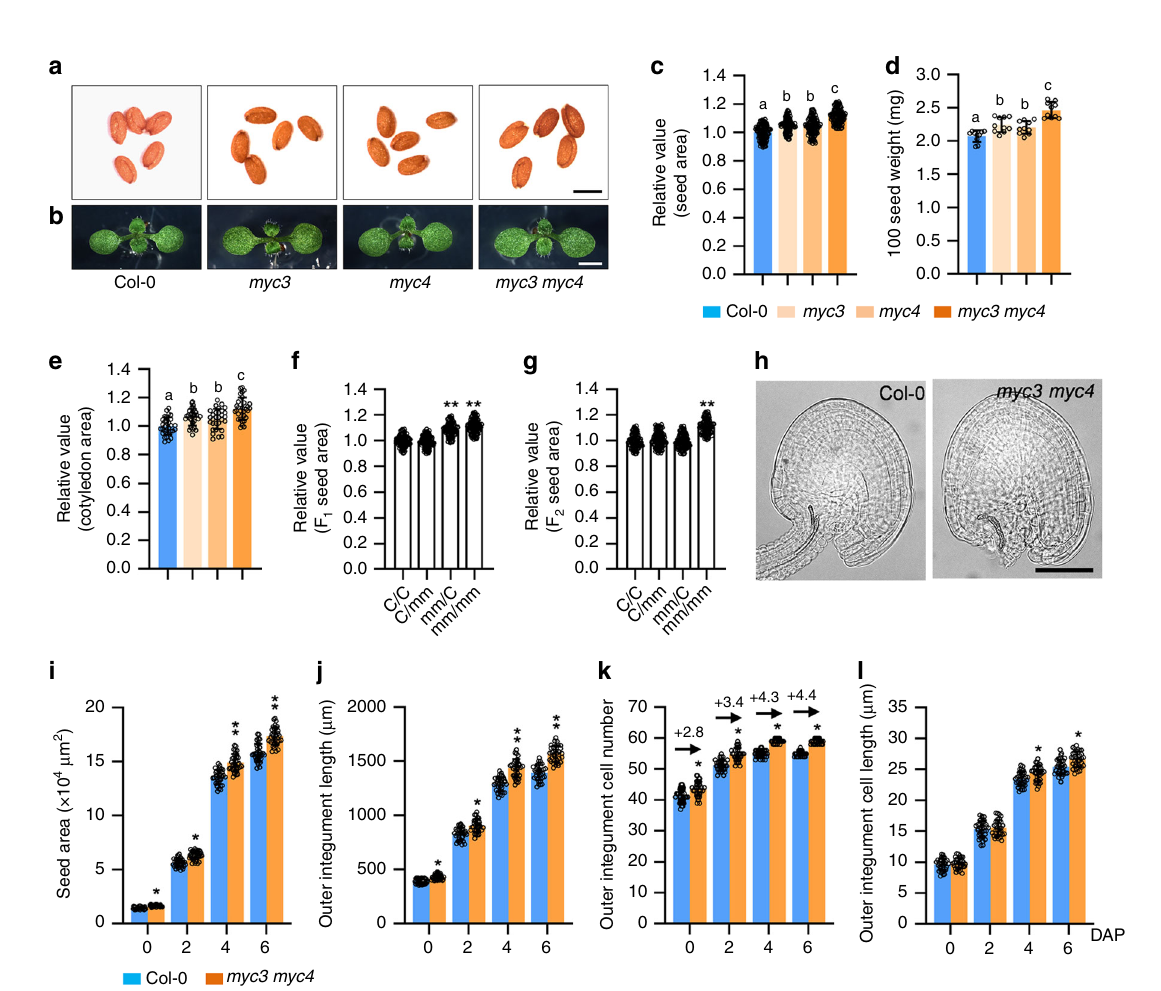
Fig. 3 MYC3 and MYC4 act maternally to control seed development. a , b The seeds ( a ) and 8-day-old seedlings ( b ) of Col-0, myc3 , myc4 , and myc3 myc4 . c – e The relative seed area ( c , n = 100), 100 seed weight ( d , n = 10), and cotyledon area ( e , n = 30) of Col-0, myc3 , myc4 and myc3 myc4 . Seeds from the third to seventh silique on the stem of six plants were used for analysis. Cotyledons from the 8-day-old seedlings were used for analysis. f , g The relative area of F 1 seeds ( f ) and F 2 seeds ( g ) from the Col-0/Col-0 (C/C), Col-0/ myc3 myc4 (C/mm), myc3 myc4 /Col-0 (mm/C), and myc3 myc4 / myc3 myc4 (mm/mm) plants (n = 100). h Ovules of Col-0 and myc3 myc4 plants at 0 DAP (days after pollination). i – l The seed area ( i ), outer integument length ( j ), outer integument cell number ( k ), and outer integument cell length ( l ) of Col-0 and myc3 myc4 plants at 0, 2, 4, and 6 DAP (n = 33). Ovules and seeds from six siliques, which were from the fourth silique on the stem of six plants, were used for analysis. Scale bars, 0.5 mm ( a ), 0.2 cm ( b ), and 50 μ m ( h ). Error bars represent ±SE. Different lowercase letters above the columns indicate the signi fi cant difference among different groups, one-way ANOVA P - values: P < 0.05. * indicates signi fi cant difference from the Col-0, one-way ANOVA P -values: * P < 0.05 and ** P < 0.01.